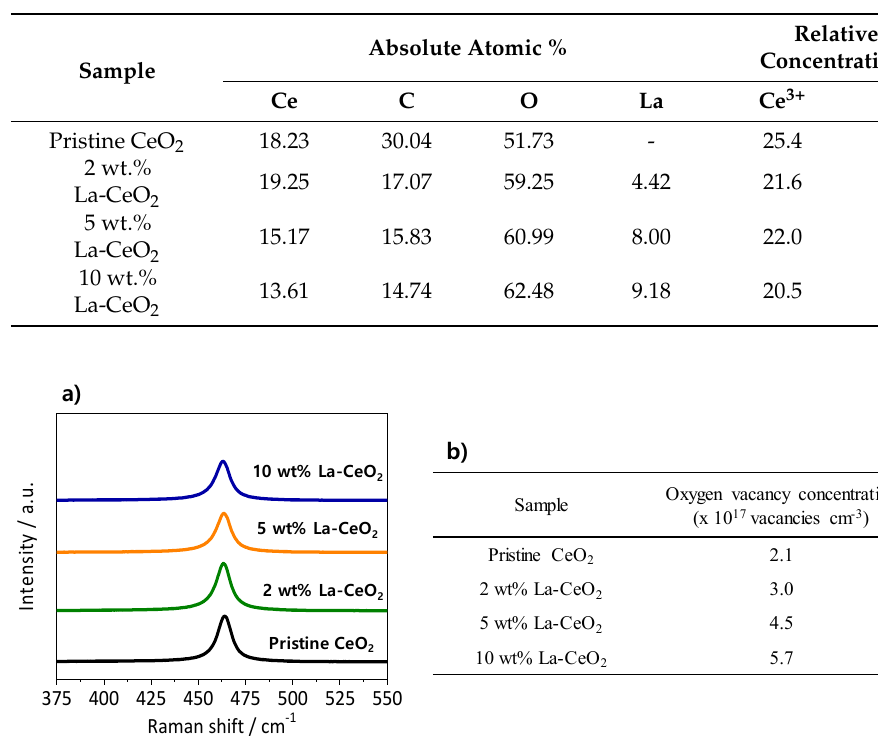
Table 2. Atomic content and the relative Ce concentration on the pristine CeO 2 and the La-doped CeO 2 NPs.